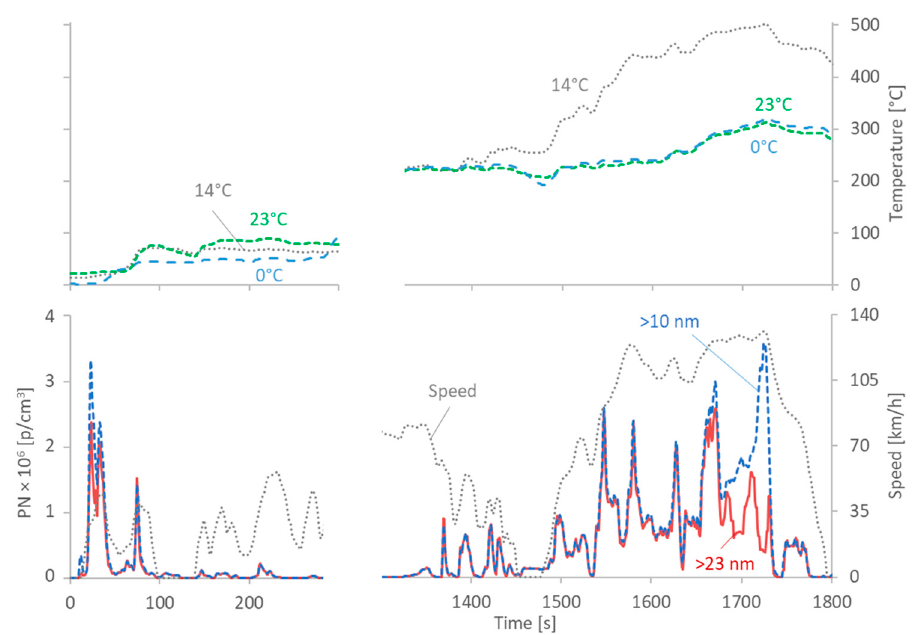
Figure 12. Particle number (PN) emissions > 23 nm and > 10 nm for the WLTC at 14 ◦ C with regeneration (lower panel). The exhaust gas temperature as measured at the tailpipe is also plotted for the specific test at 14 ◦ C, and two others at 0 ◦ C and 23 ◦ C (upper panel). Note that the x axis is split to present the cold start section, and the section when the DPF (Diesel Particulate Filter) regeneration takes place. WLTC = Worldwide Light-duty Test Cycle.